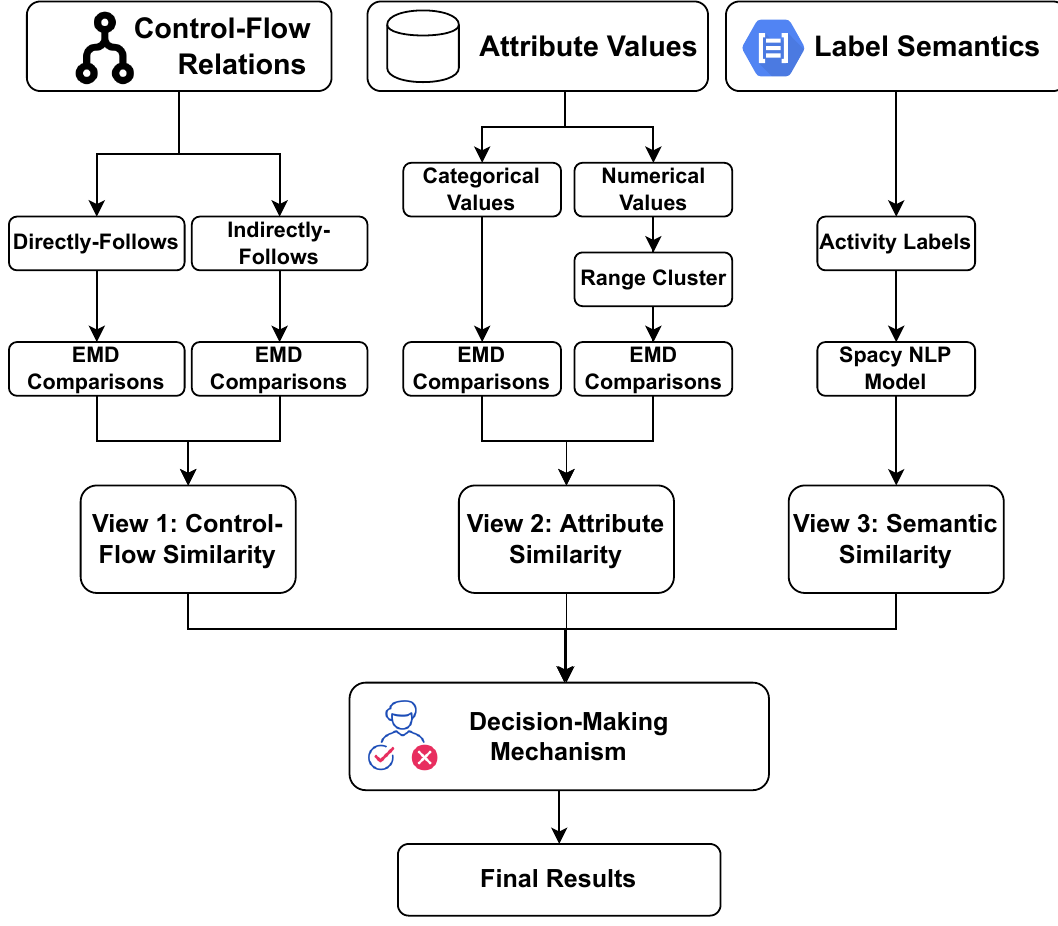
Figure 4. Overview of the proposed framework